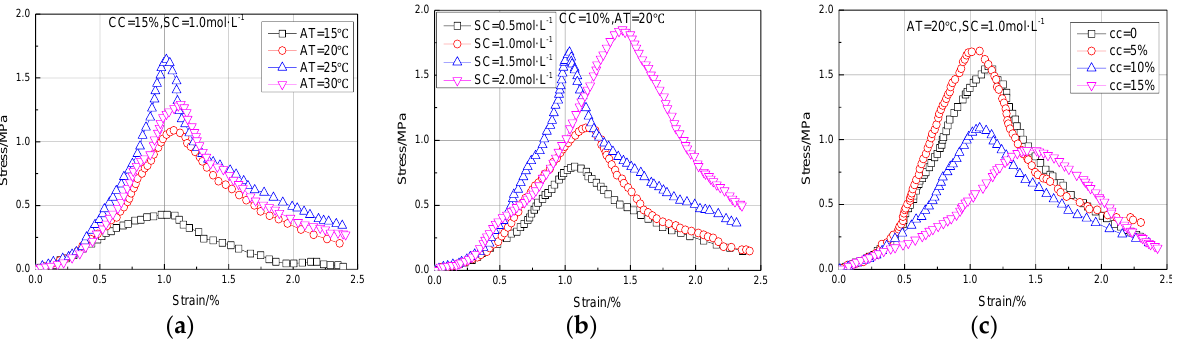
Figure 6. Test results under different conditions of AT, SC, and CC. ( a ) Group A. ( b ) Group B. ( c ) Group C.